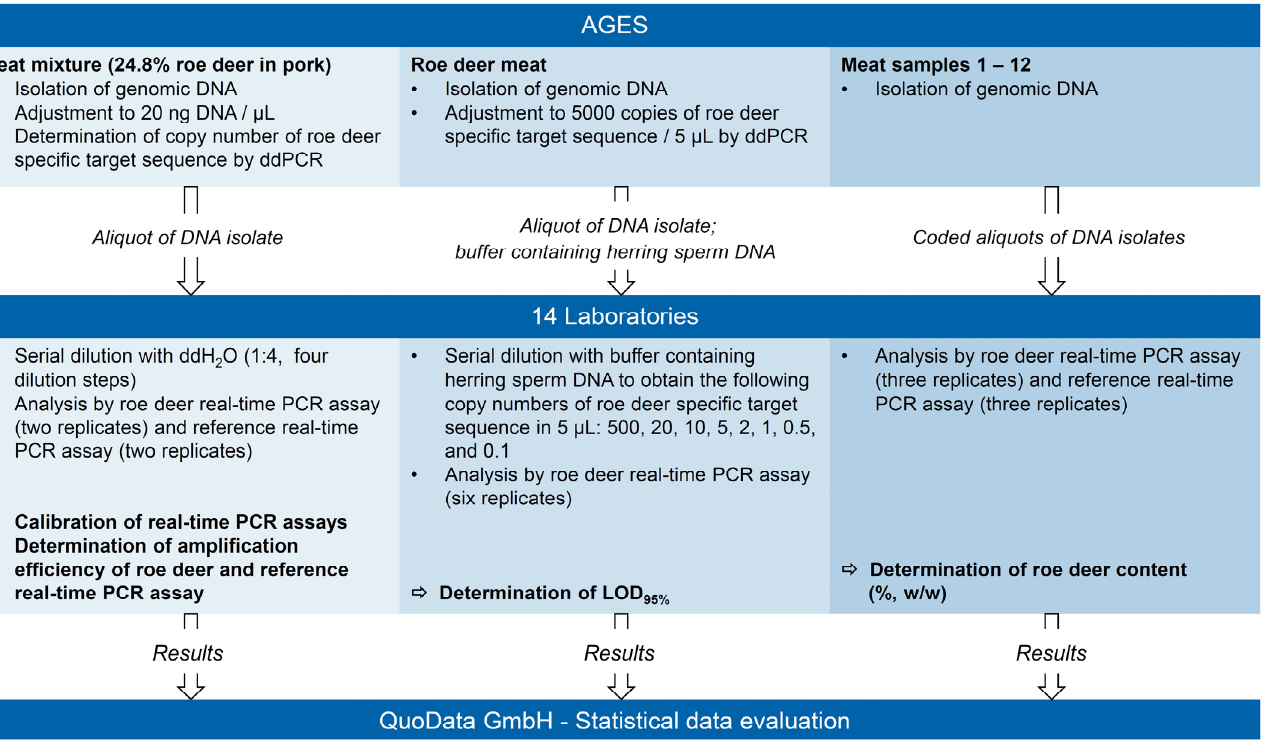
Figure 1. Design of the interlaboratory ring trial.